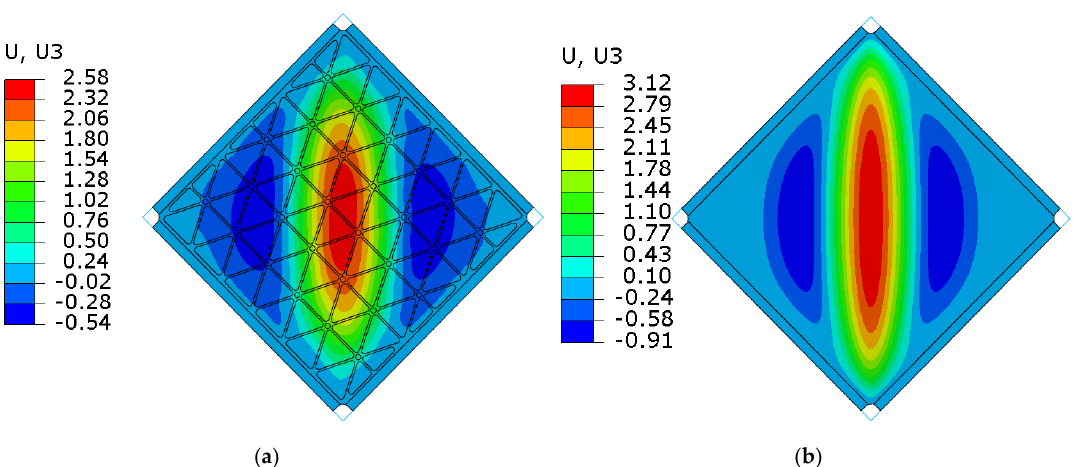
Figure 21. Comparison of horizontal cross-section deflections at the maximum load level equal to 103 N/mm.